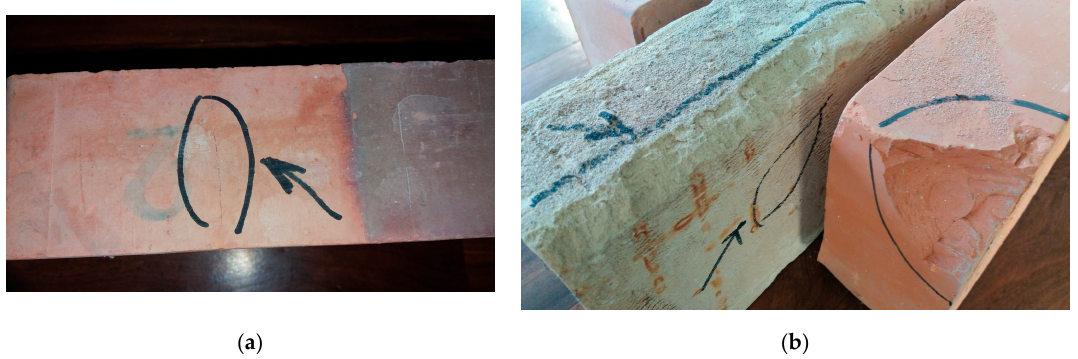
Figure 1. Typical appearance of non-resistant bricks after 25 freeze-thaw cycles, ( a ) damage in the form of cracking; ( b ) damage in the form of delamination.